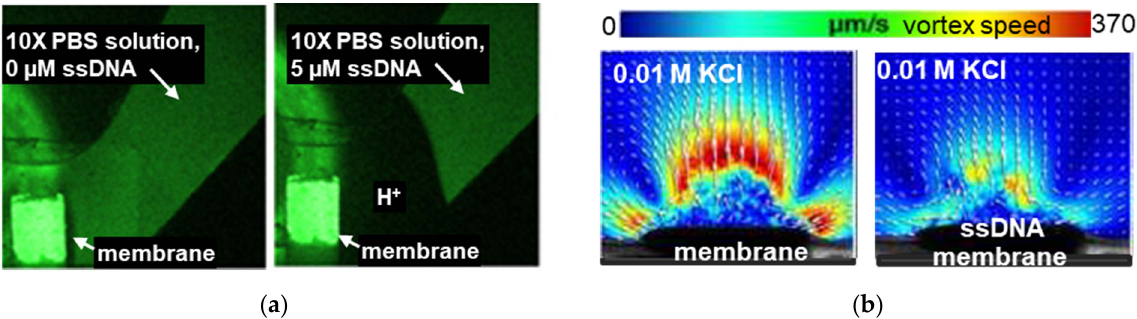
Figure 10. Results of visualization of the front of protons formed due to water splitting ( a ) and electroconvective vortices ( b ) at the surface of the anion-exchange membrane. On the left is the pristine membrane; on the right is a membrane on the surface of which single-stranded DNA (ssDNA, which contains dissociated phosphonate groups) is adsorbed. Adapted from [191,192].